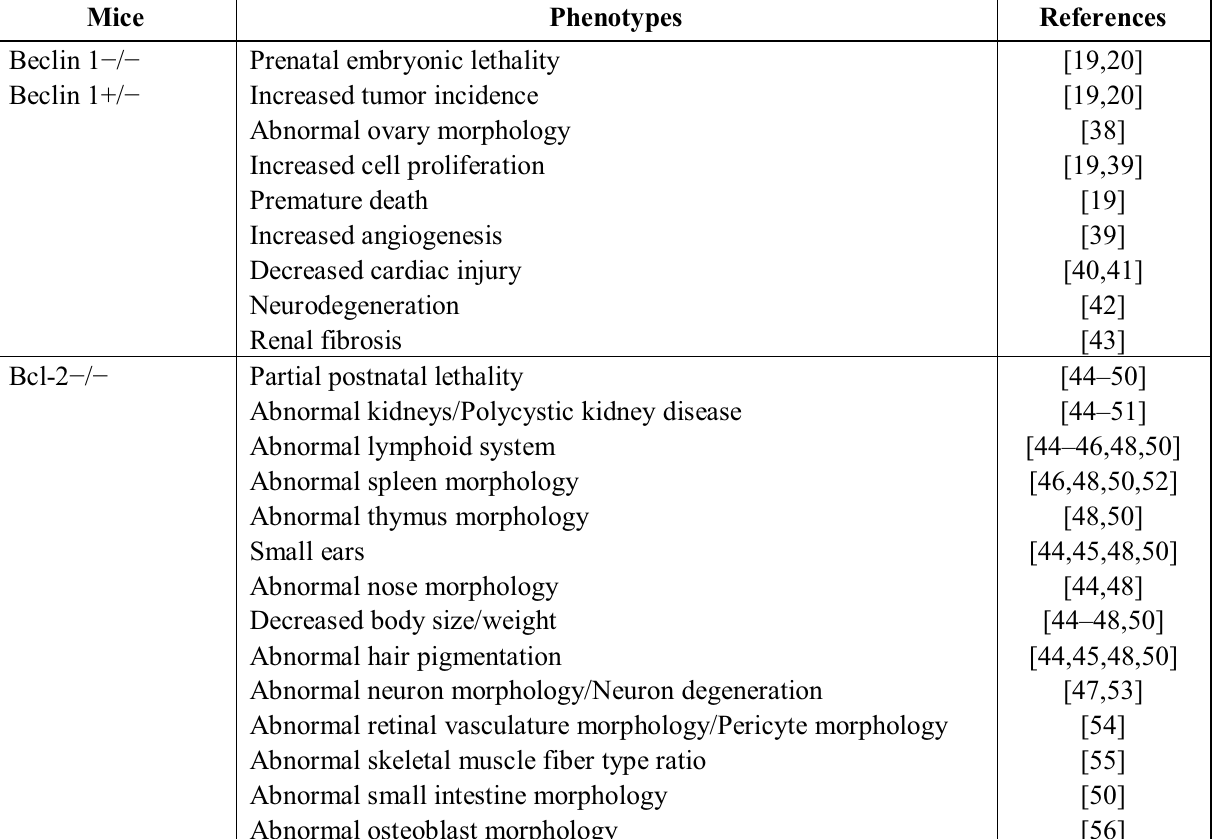
Table 1. List of examples of phenotypes observed in mice deficient in Beclin 1, Bcl-2, Bcl-X , Mcl-1 and Bcl-w. When homozygous ( (cid:237) / (cid:237) ) knockout mice are L